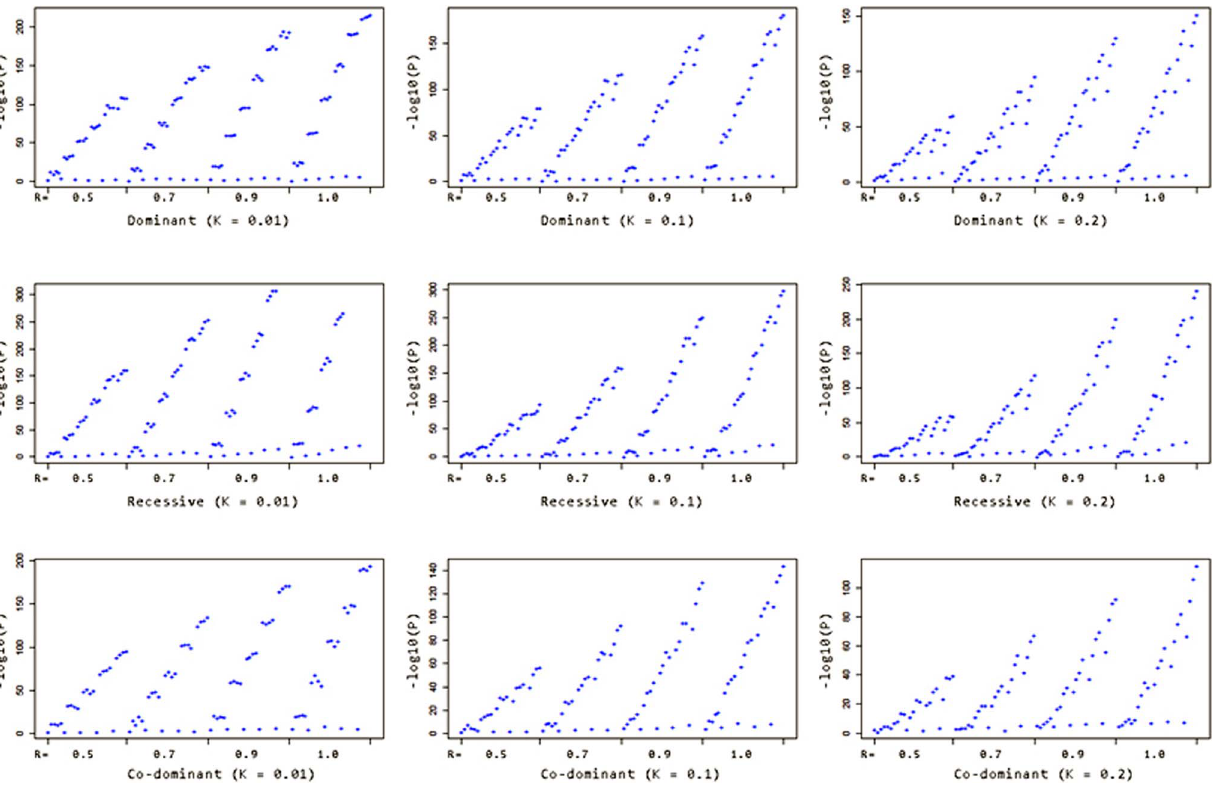
Figure 5. –log 10 ( P ) distribution of nine disease models from the simulation results. Graphs from the top row to the bottom row represent the dominant, recessive and codominant models respectively, and from left to right represent the results with three different K values (0.01, 0.1 and 0.2). Each blue dot corresponds to a –log 10 ( p-value ) under that specific setting. Every graph is broken down into four bins with R=0.5, 0.7, 0.9 and 1.0. Within each bin, the –log 10 ( p-values ) are ordered by descending f 11 and increasing f 12 & f 22 .